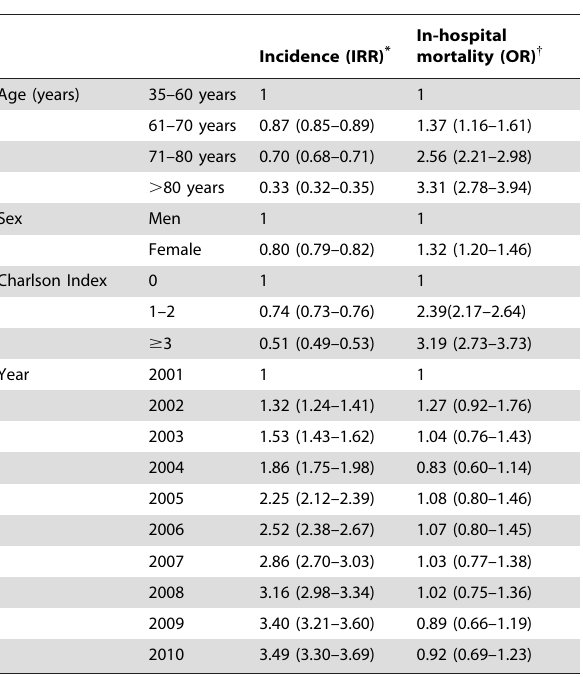
Table 4. Multivariate analysis of the factors associated with cumulative incidence and mortality after percutaneous coronary intervention in patients with type 2 diabetes in Spain,